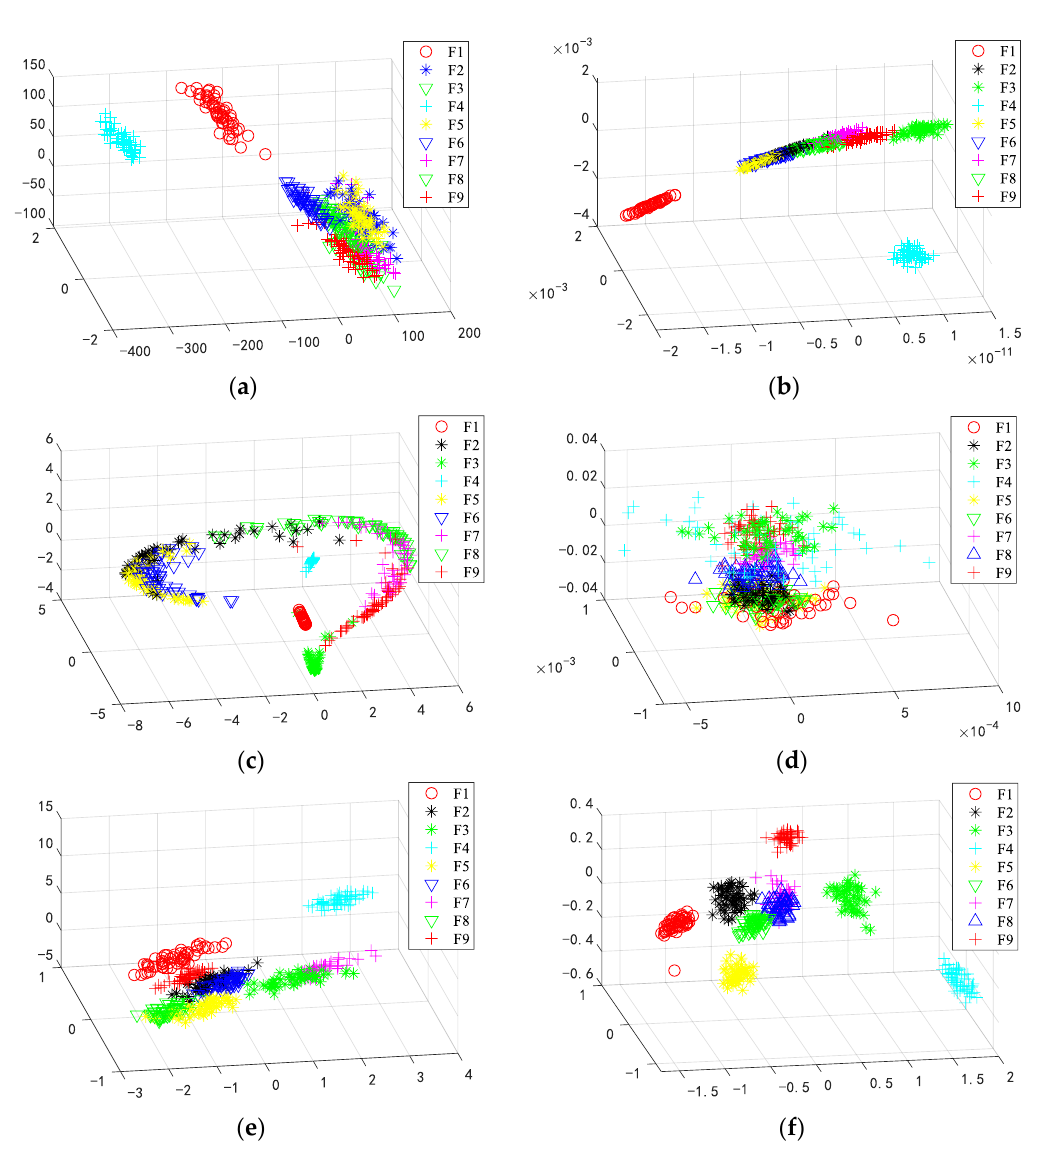
Figure 13. Three-dimensional distribution of test gear samples: ( a ) LLE; ( b ) LPP; ( c ) KPCA; ( d ) OLGPP; ( e ) LSPD; ( f ) ESBDP.